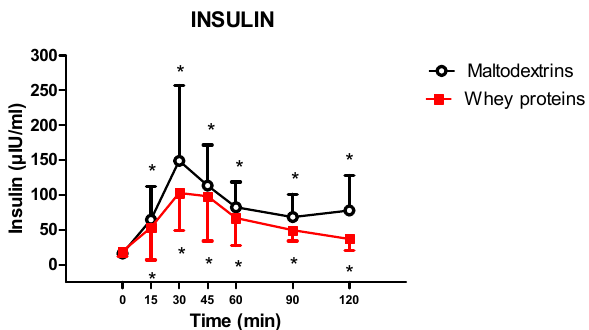
Figure 4. Changes of glucose ( top ) and insulin ( bottom ) levels in young obese subjects after the intake of a drink (completely within 15 min and starting at T0), containing whey proteins or maltodextrins. See the text for further details. Values are expressed as mean ± SD. The number of subjects was 9. * p < 0.05 vs. the corresponding T0 value; and × p < 0.05 vs. the corresponding value of the maltodextrins-treated group. A two-way ANOVA with repeated measures (with the two factors, time and group, and the interaction time × group), followed by the post hoc Tukey’s test, was used.